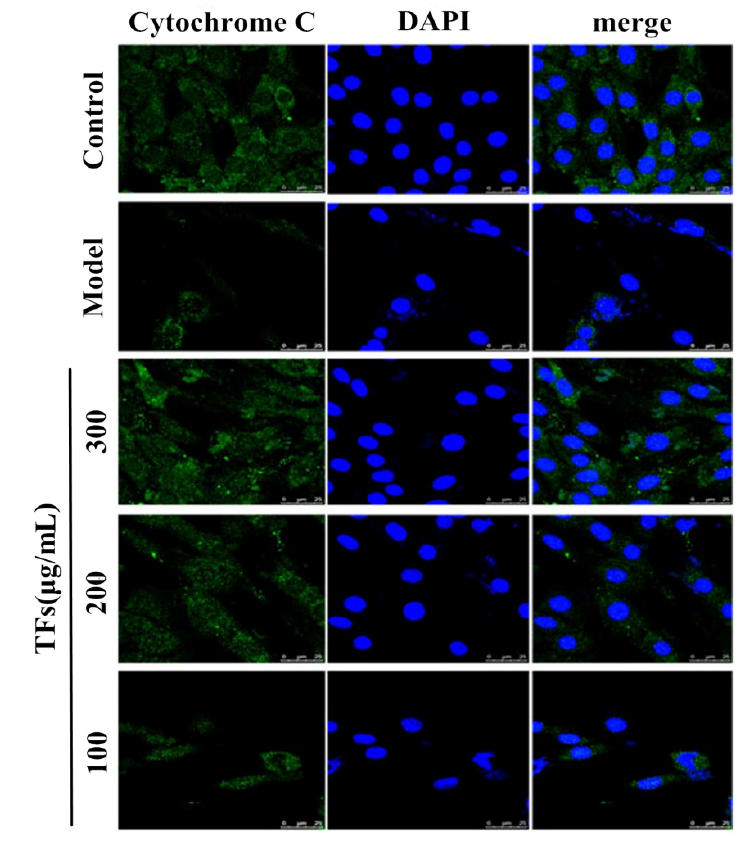
Figure 4. Immunofluorescence of cytochrome C from mitochondrion to cytoplasm (800×, final